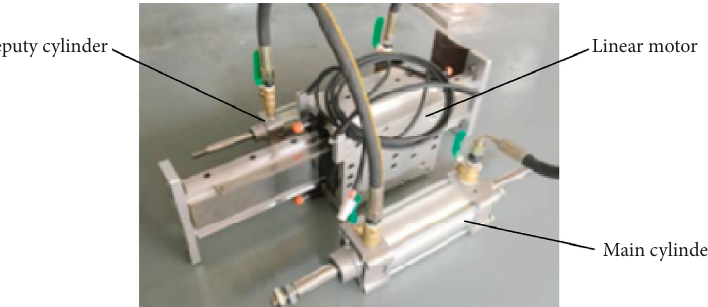
Figure 1: Structure diagram of the hydraulic electric inerter.